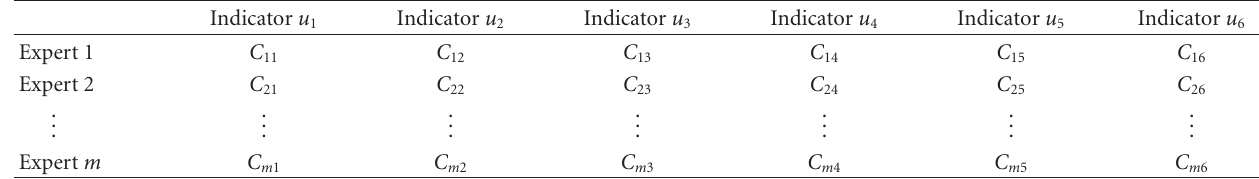
Table 2: The grading values of m